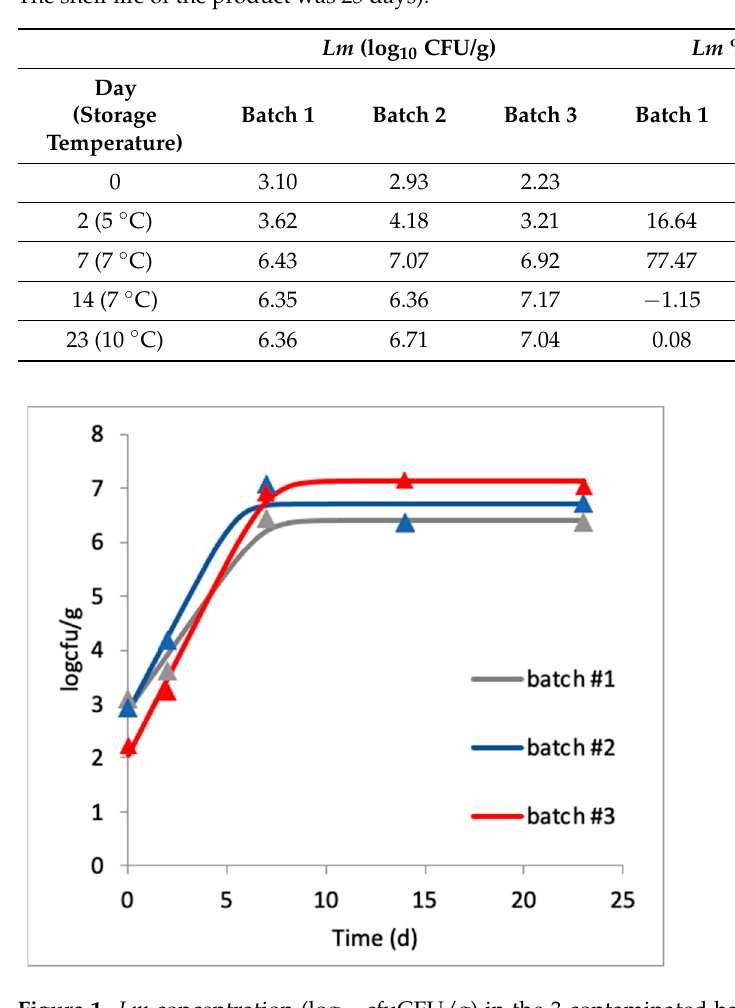
Figure 1. Lm concentration (log 10 cfuCFU/g) in the 3 contaminated batches of ready-to-eat food (cheese) during storage at 5 °C, 7 °C, and 10 °C in the studied period (“Day 0” = day of inoculation, “Day End” = end of shelf life, that is, the 23rd day upon receipt of the batches at their 2nd day of production. The shelf life of the product was 25 days). (The dots indicate experimental values and the lines correspond to the predictions by the Baranyi model, R 2 = 0.956–0.987). The growth potential ( ∆ ), that is, the difference between the highest observed Lm concentration in log 10 CFU/g during the challenge test (log max ) and the initial